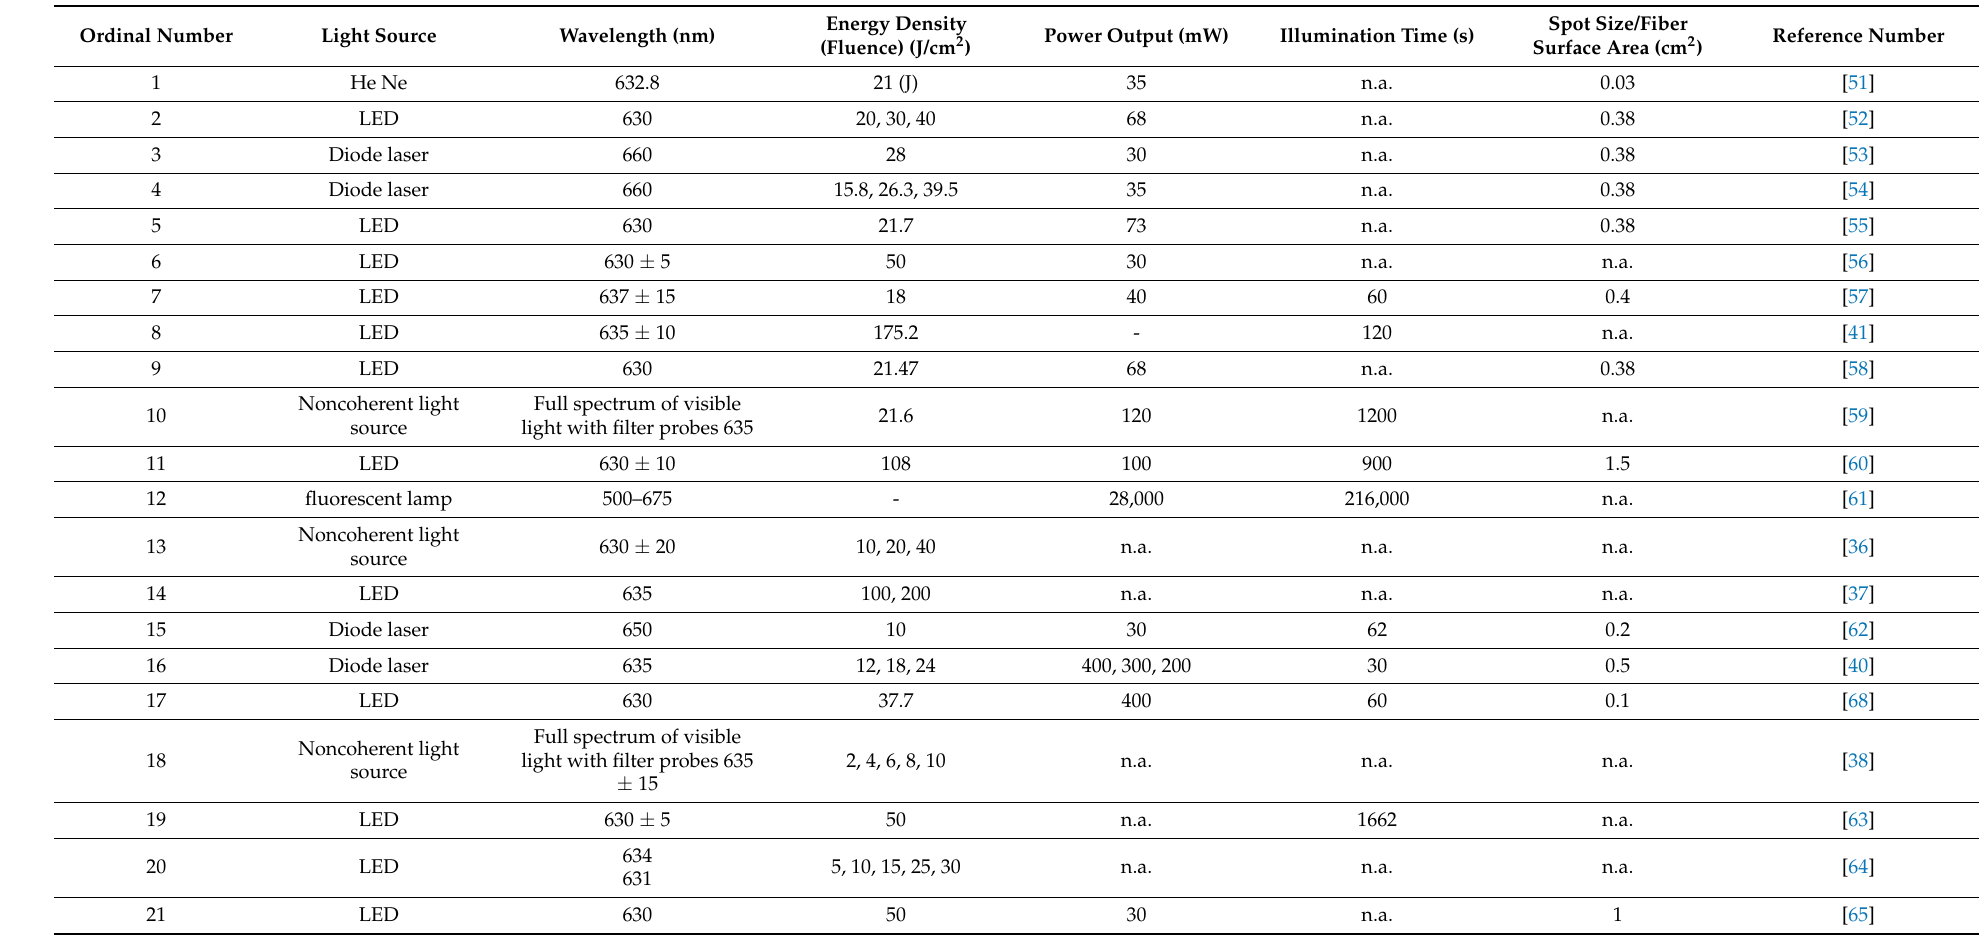
Table 3. Light sources physical parameters of studies that fulfilled the eligibility